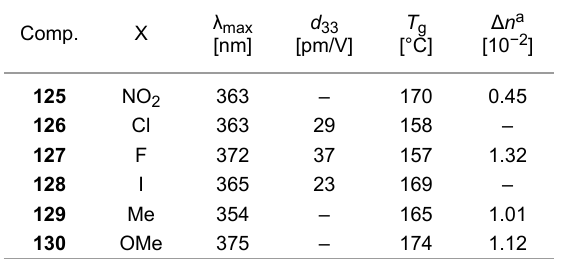
Table 15: Properties of polyphosphazenes 125 – 130 [125-127].